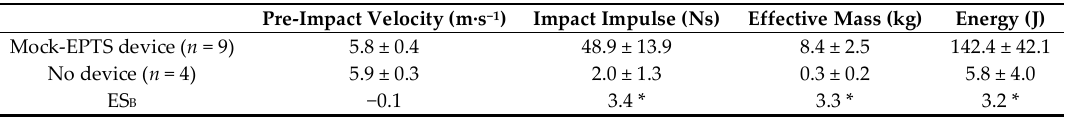
Table 1. Kinetic and kinematic parameters associated with the upper-back during unexpected, backward